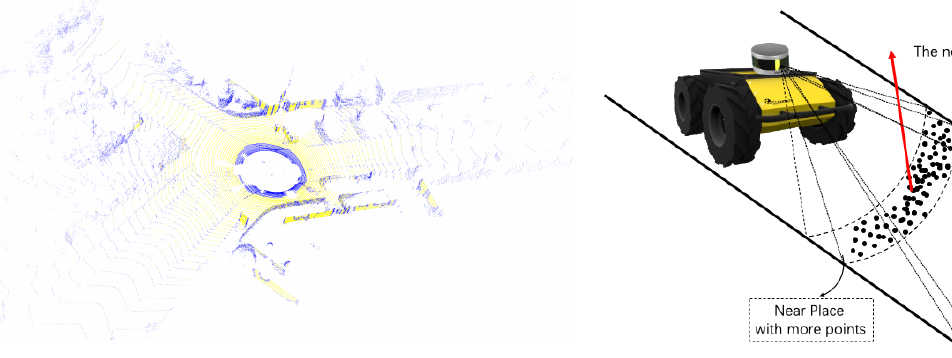
Figure 4. The extracted features. Point features are colored in red and surf features are colored in yellow.